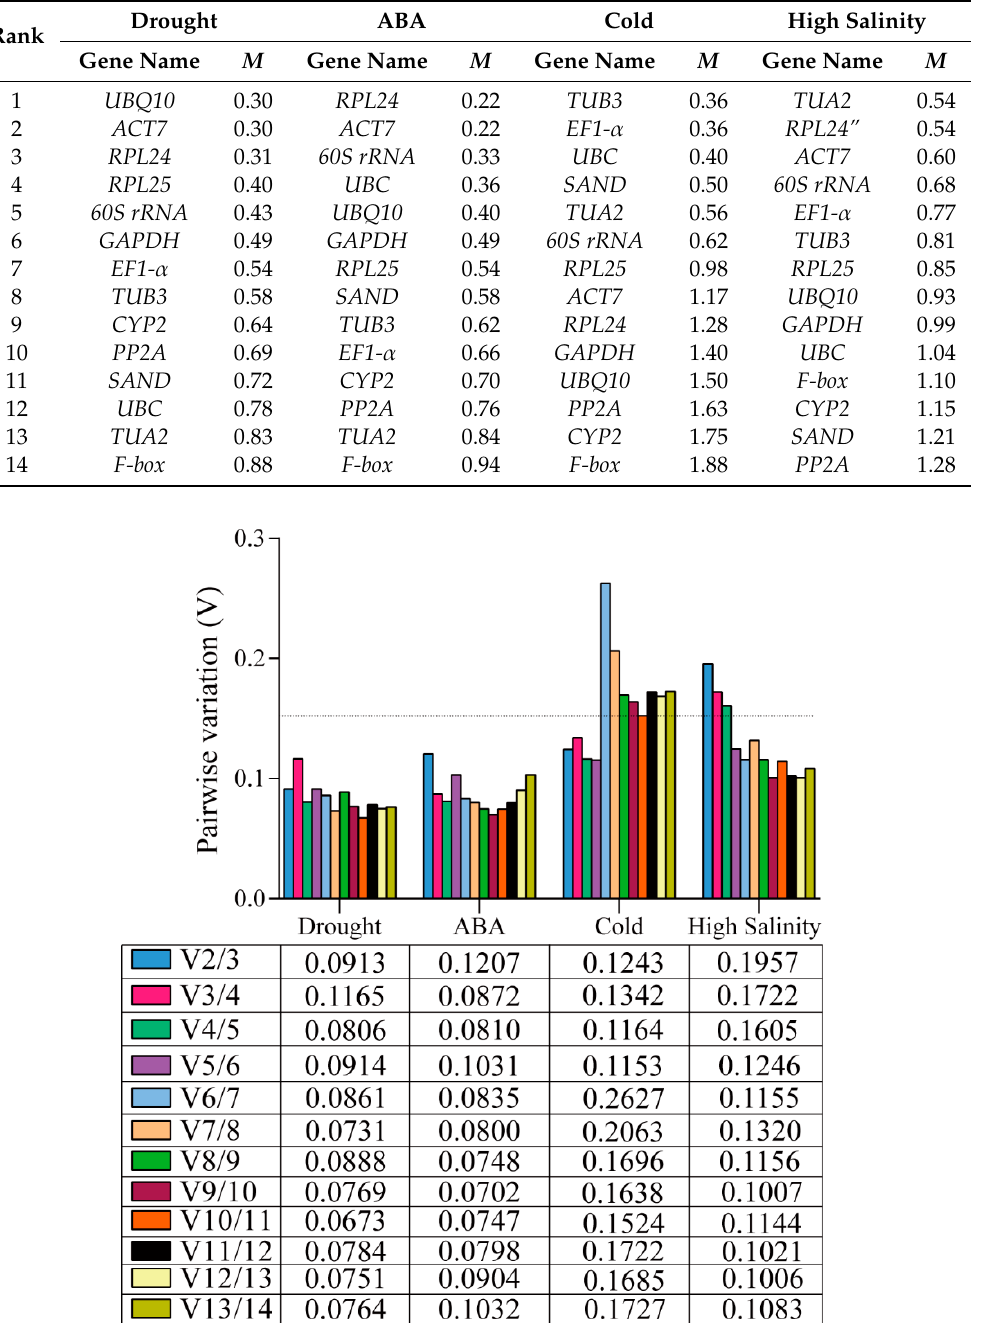
Table 2. Expression stability of candidate reference genes calculated by geNorm.